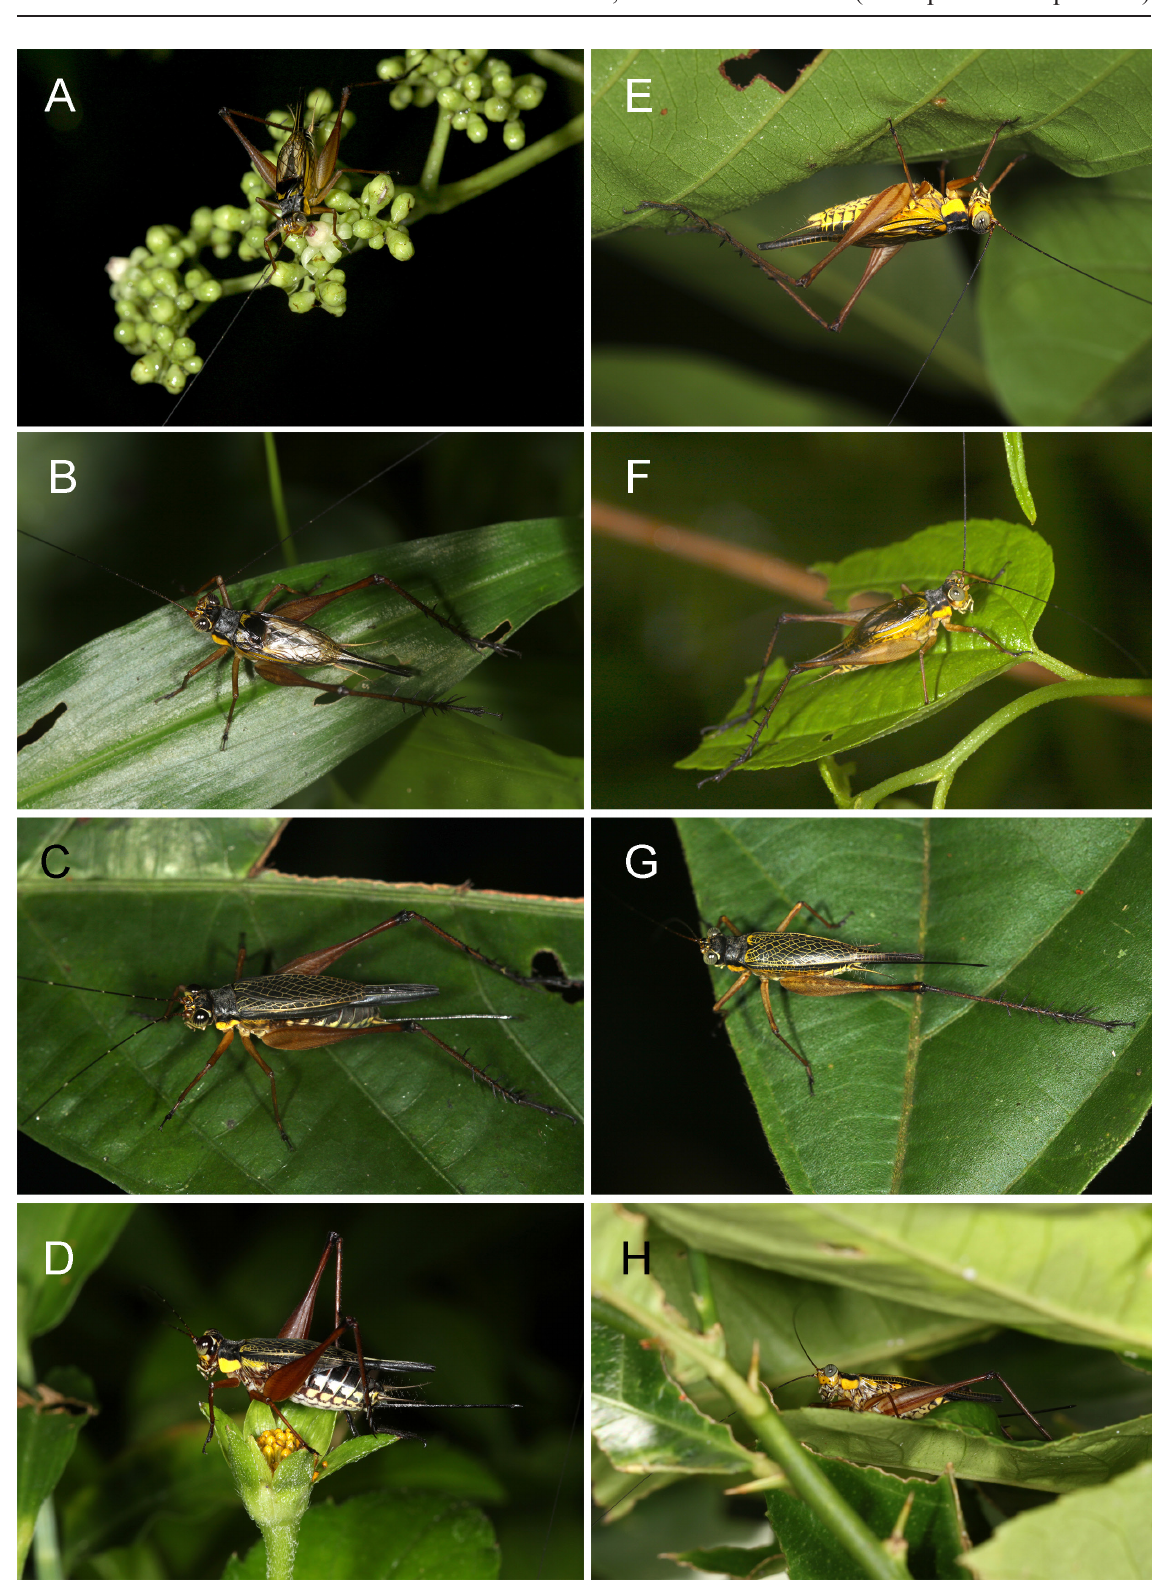
Fig. 23. A–D . Nisitrus malaya Robillard & Tan sp. nov. E–H . N. vittatus (Haan, 1844). Adult ♂♂ (A–B, E–F) and ♀♀ (C–D, G–H) in their natural environment. Photograph credit: Ming Kai